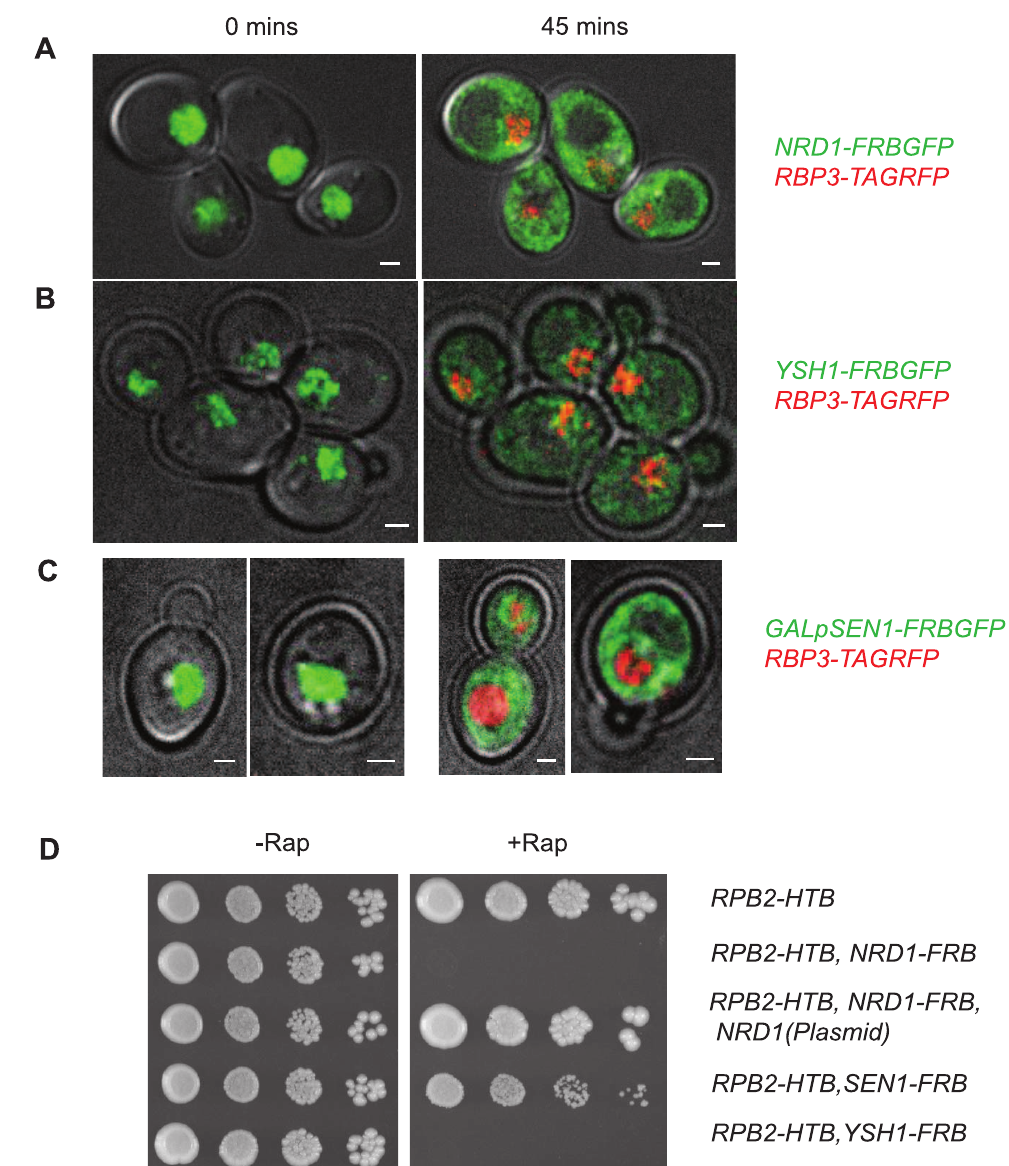
Figure 1. Nuclear depletion of Pol II termination factors. Live yeast cell imaging of: A. NRD1-FRBGFP, RPB3-TAGRFP ; B. YSH1-FRBGFP, RPB3- TAGRFP ; C. GALpSEN1-FRBGFP, RPB3-TAGRFP strains. Time after rap treatment is indicated above the pictures. D. Growth of indicated FRB strains on CSM plates with and without rap.